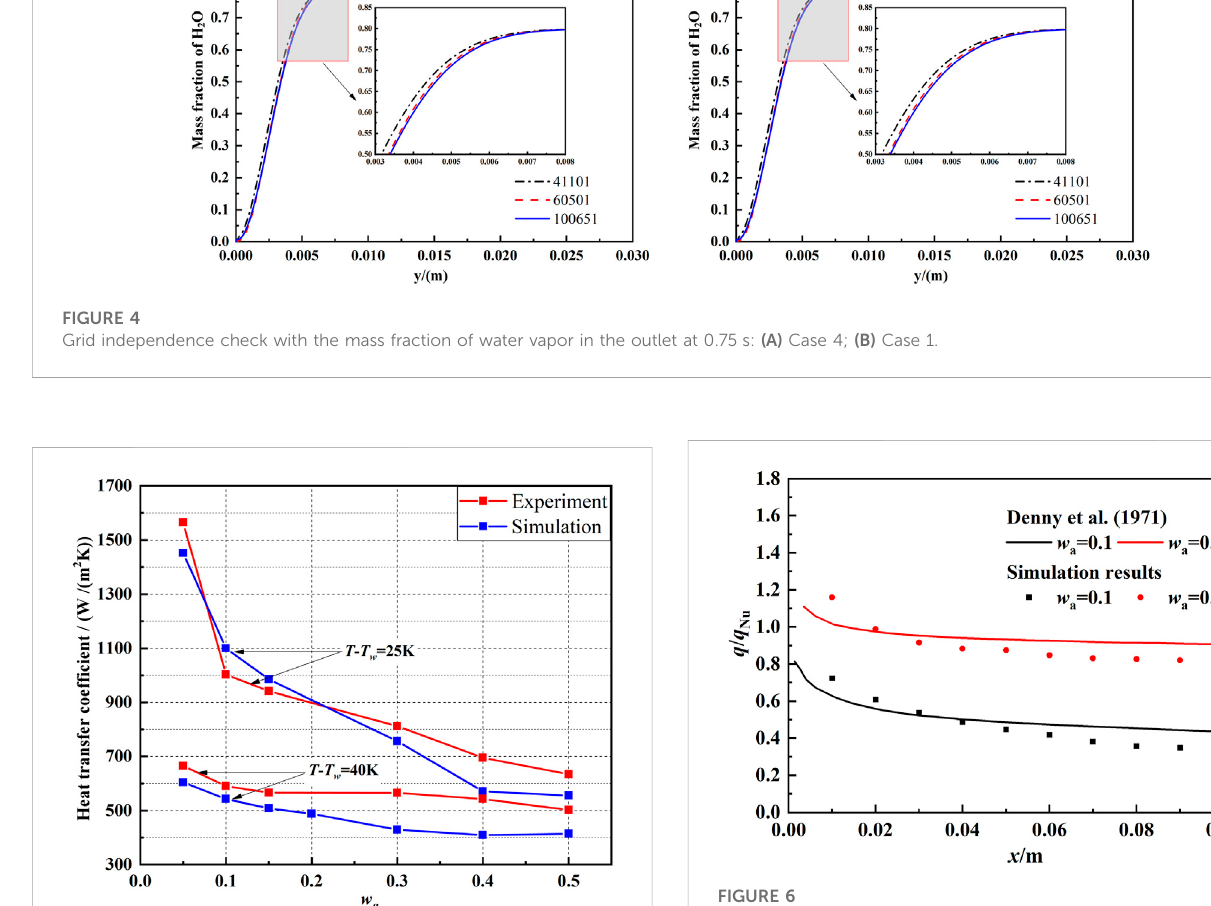
FIGURE 6 Ratio of heat fl ux to that from Nusselt ’ s model obtained in our simulation and theanalyticalsolution ofDenny etal. (1971) ( u g = 3.04 m/ s, T - T w = 22.23